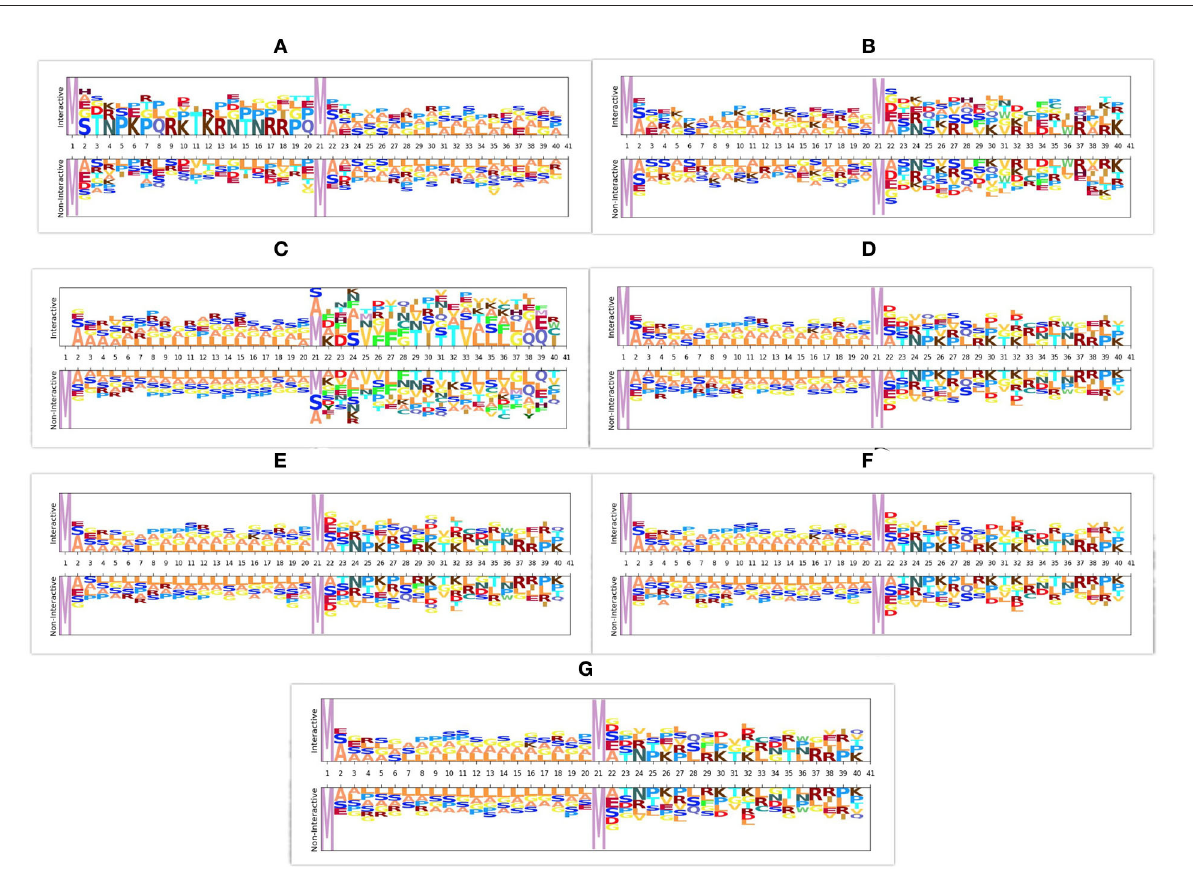
FIGURE3 Distribution of amino acid sequences across 7 different datasets. For each dataset the distribution of amino acids is shown across interactive and non-interactive protein samples, (A) Barman dataset (B) Denovo dataset (C) Coronavirus dataset (D) TR1-TS1 dataset (E) TR2-TS2 dataset (F) TR3-TS1 dataset (G) TR4-TS2